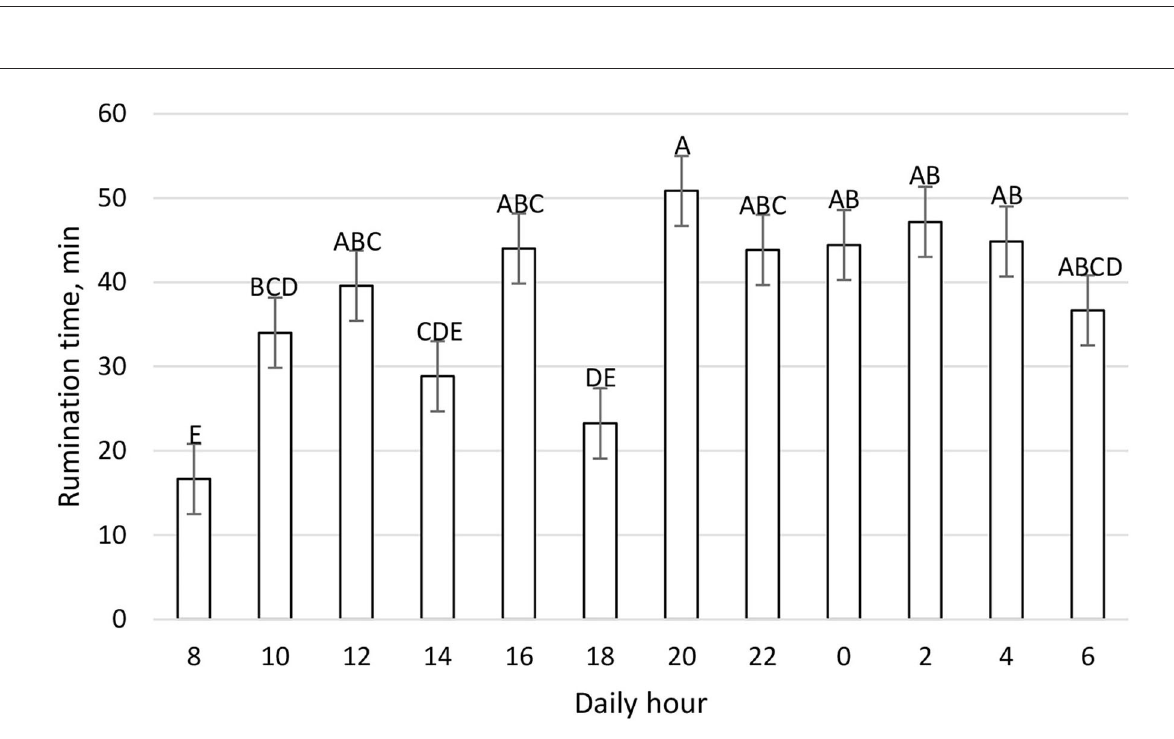
FIGURE5 Daily rumination time (min) patter (LSM ± SE) on a 2h basis during the fecal sampling period. Letters for differences ≤ 0.05. Each time point refers to 2h rumination. P-value < 0.01; SEM =